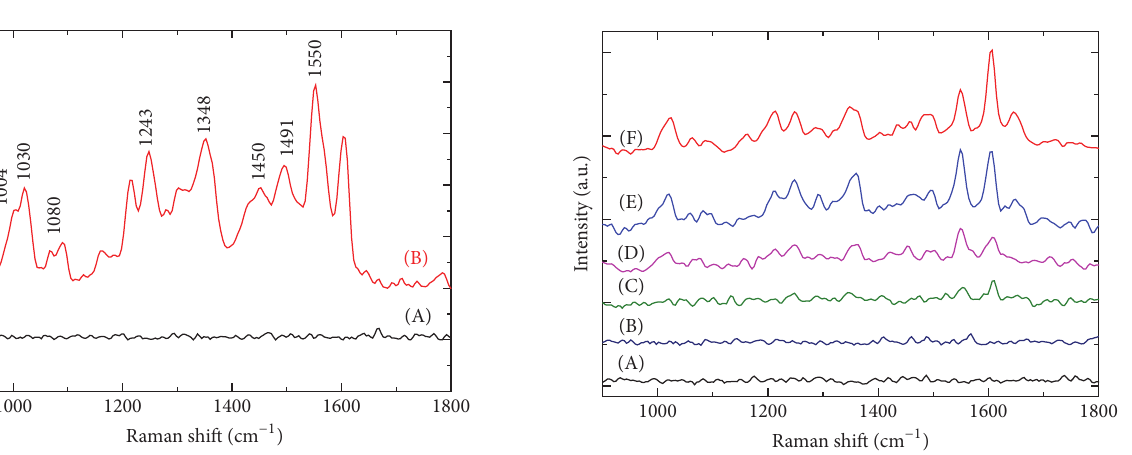
Figure 3: SERS spectra of Z-CPPs and Au-Z-CPPs according to the ZnTPyP molecule concentration varying from 500 to 10nmol: (A) originalZ-CPPssolution,Au-Z-CPPswith(B)10nmol,(C)20nmol,